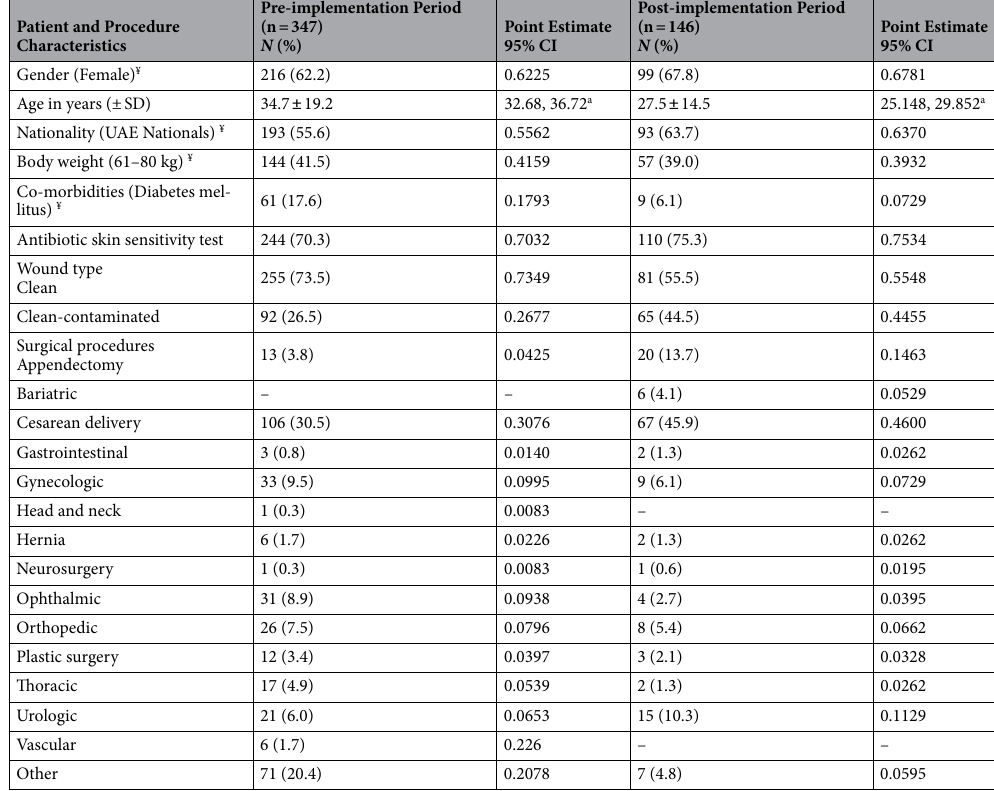
Table 3. Patient and procedure characteristics in pre and post-implementation periods. ¥ Major characteristic. a 95% confidence interval (CI) calculated using Z statistics.